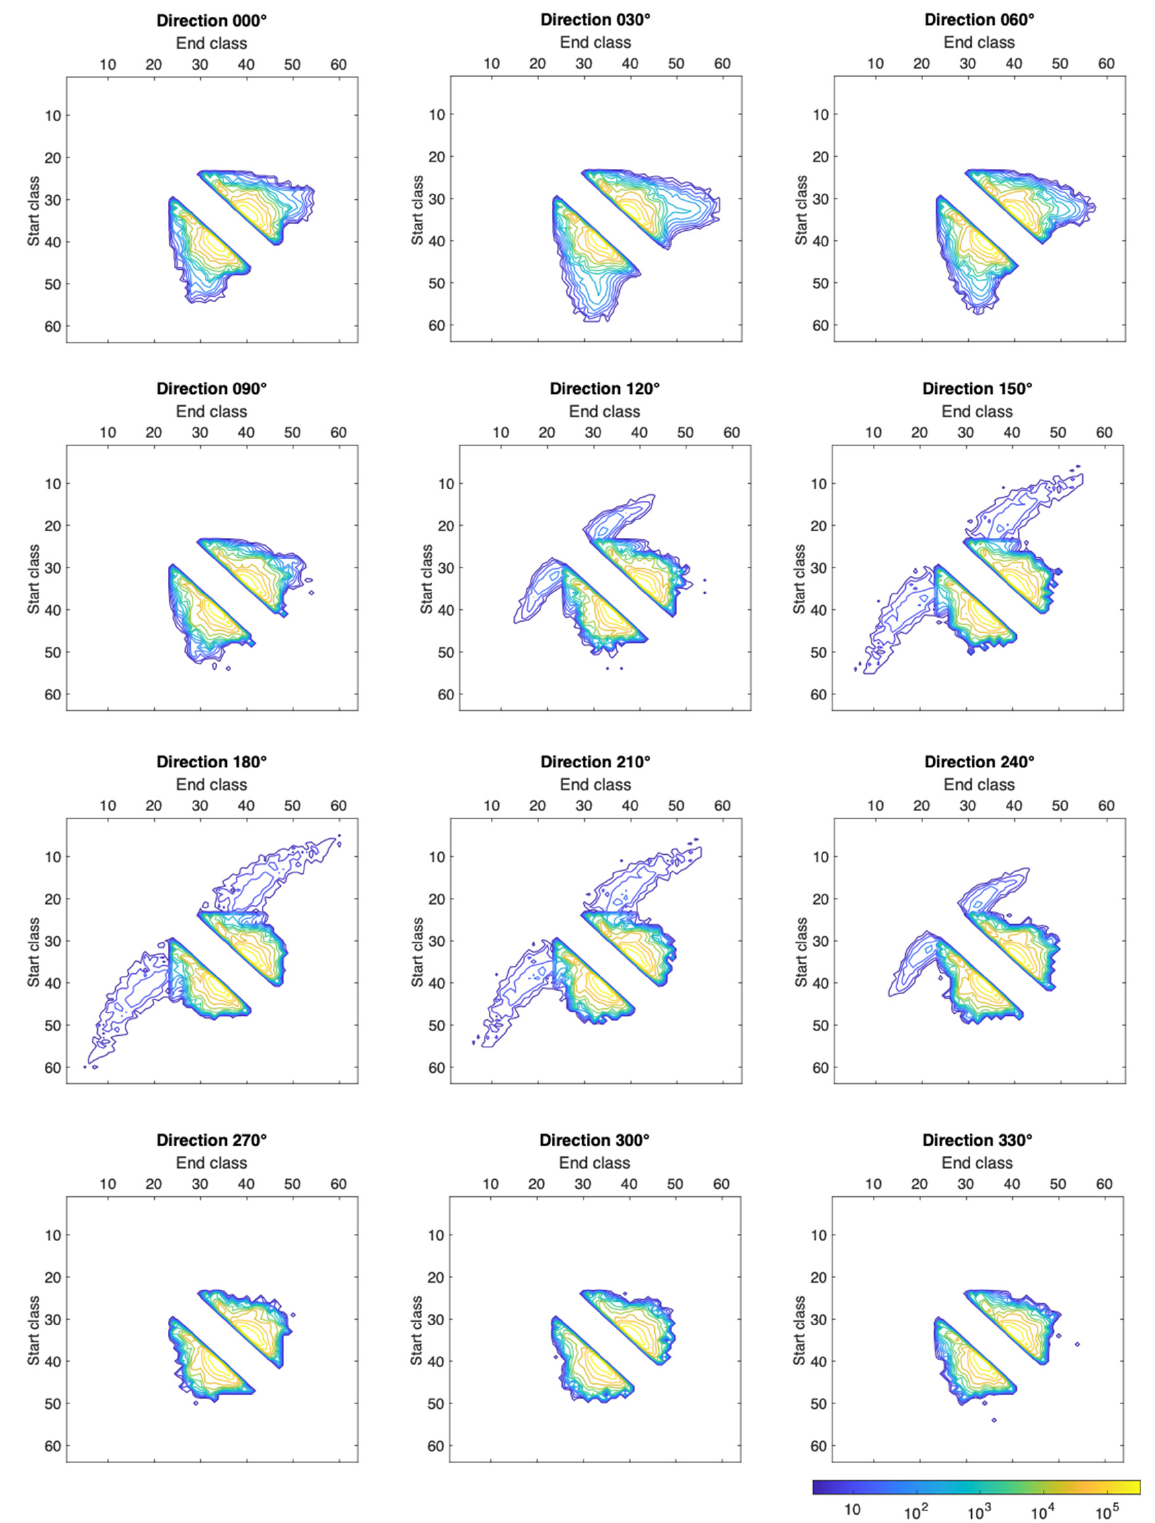
Figure 7. Markov matrices with global 64 stress classes for all 12 directions for one year.